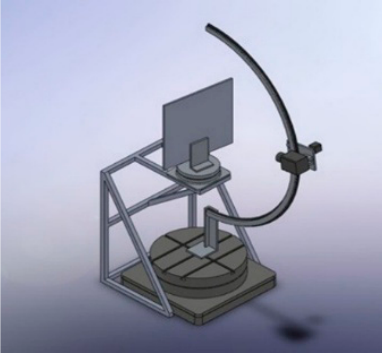
Figure 6. The three-dimensional schematic diagram of the frame structure.